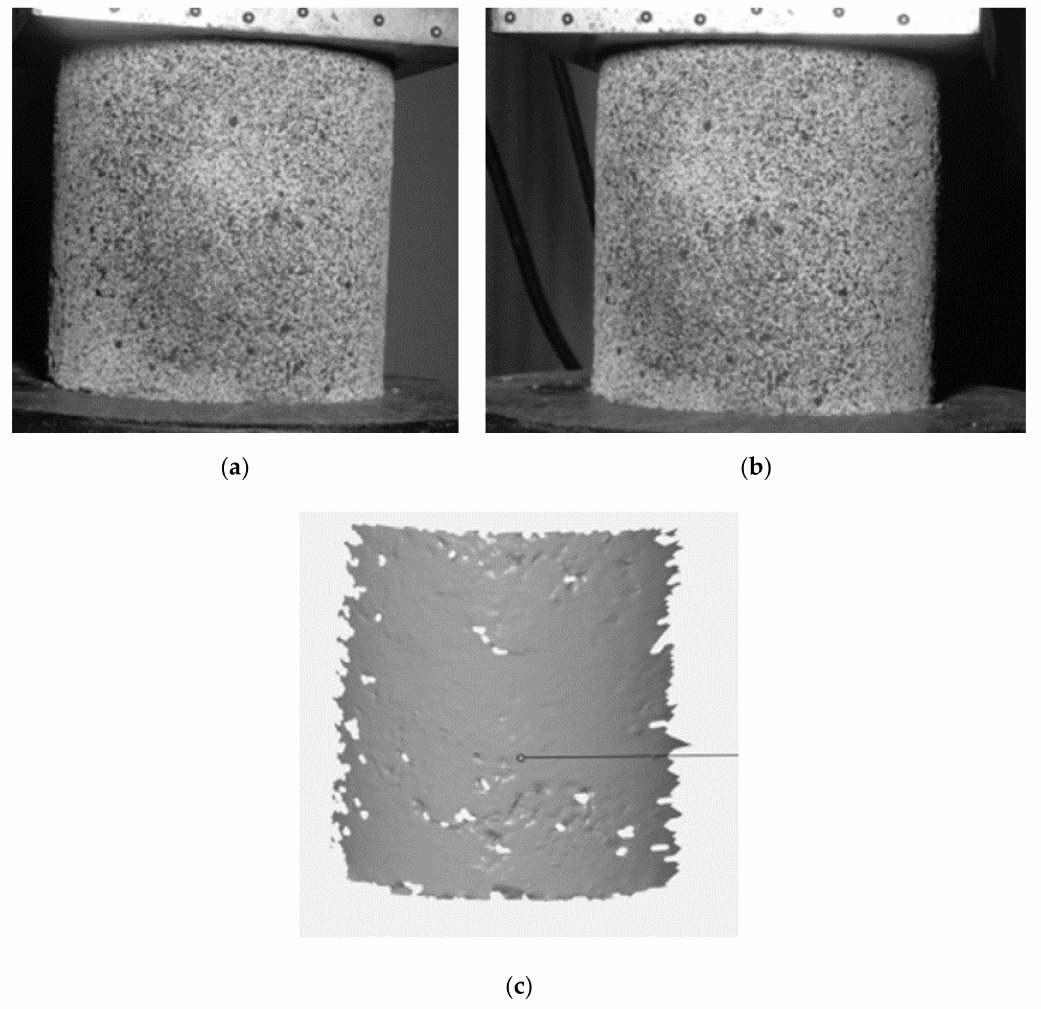
Figure 3. ( a ) Left camera image; ( b ) Right camera image; ( c ) 3D model built from camera images (photo: K.